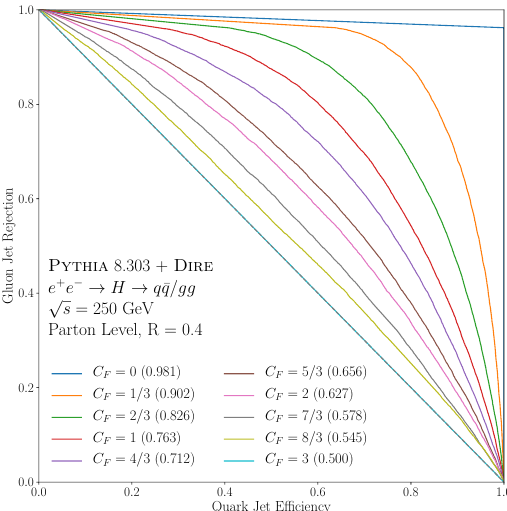
Figure 2 . ROC curves for PFN quark/gluon jet classification over a range of quark color factors C F . AUC scores are shown next to each legend entry. At each C F setting, q → qg and g → gg splitting functions are configured to be identical up to the color factor. As expected, quark and gluon jets are indistinguishable at C F = C A = 3 and nearly perfectly distinguishable at C F = 0 . an enhancement of quark jet multiplicity. In both the R = 0 . 4 and R = 1 . 0 cases, multi- plicity and n (2) match PFN [ z ] — the PFN trained on constituent z both multiplicity and n (2) capture virtually all of the useful information encoded in the constituent